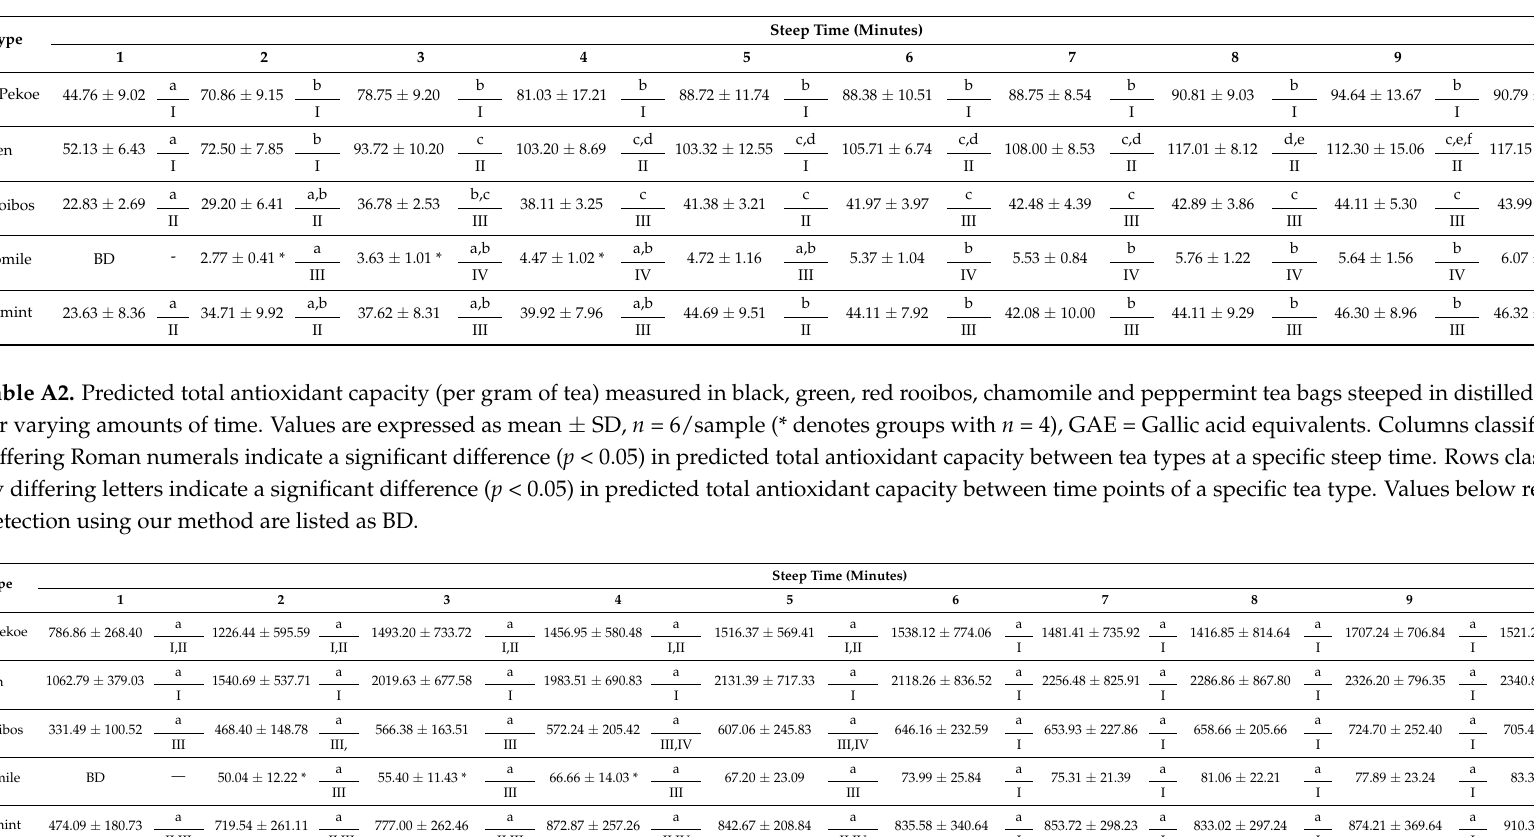
Table A1. TPC (in mg GAE/g of tea) measured in black, green, red rooibos, chamomile and peppermint tea bags steeped in distilled water for varying amounts of time. Values are expressed as mean ± standard deviation, n = 6/sample (* denotes groups with n = 4), GAE = Gallic acid equivalents. Columns classified by differing Roman numerals indicate a significant difference ( p < 0.05) in TPC between tea types at a specific steep time. Rows classified by differing letters indicate a significant difference ( p < 0.05) in TPC between time points of a specific tea type. Values below reliable detection using our method are listed as BD (below detection).